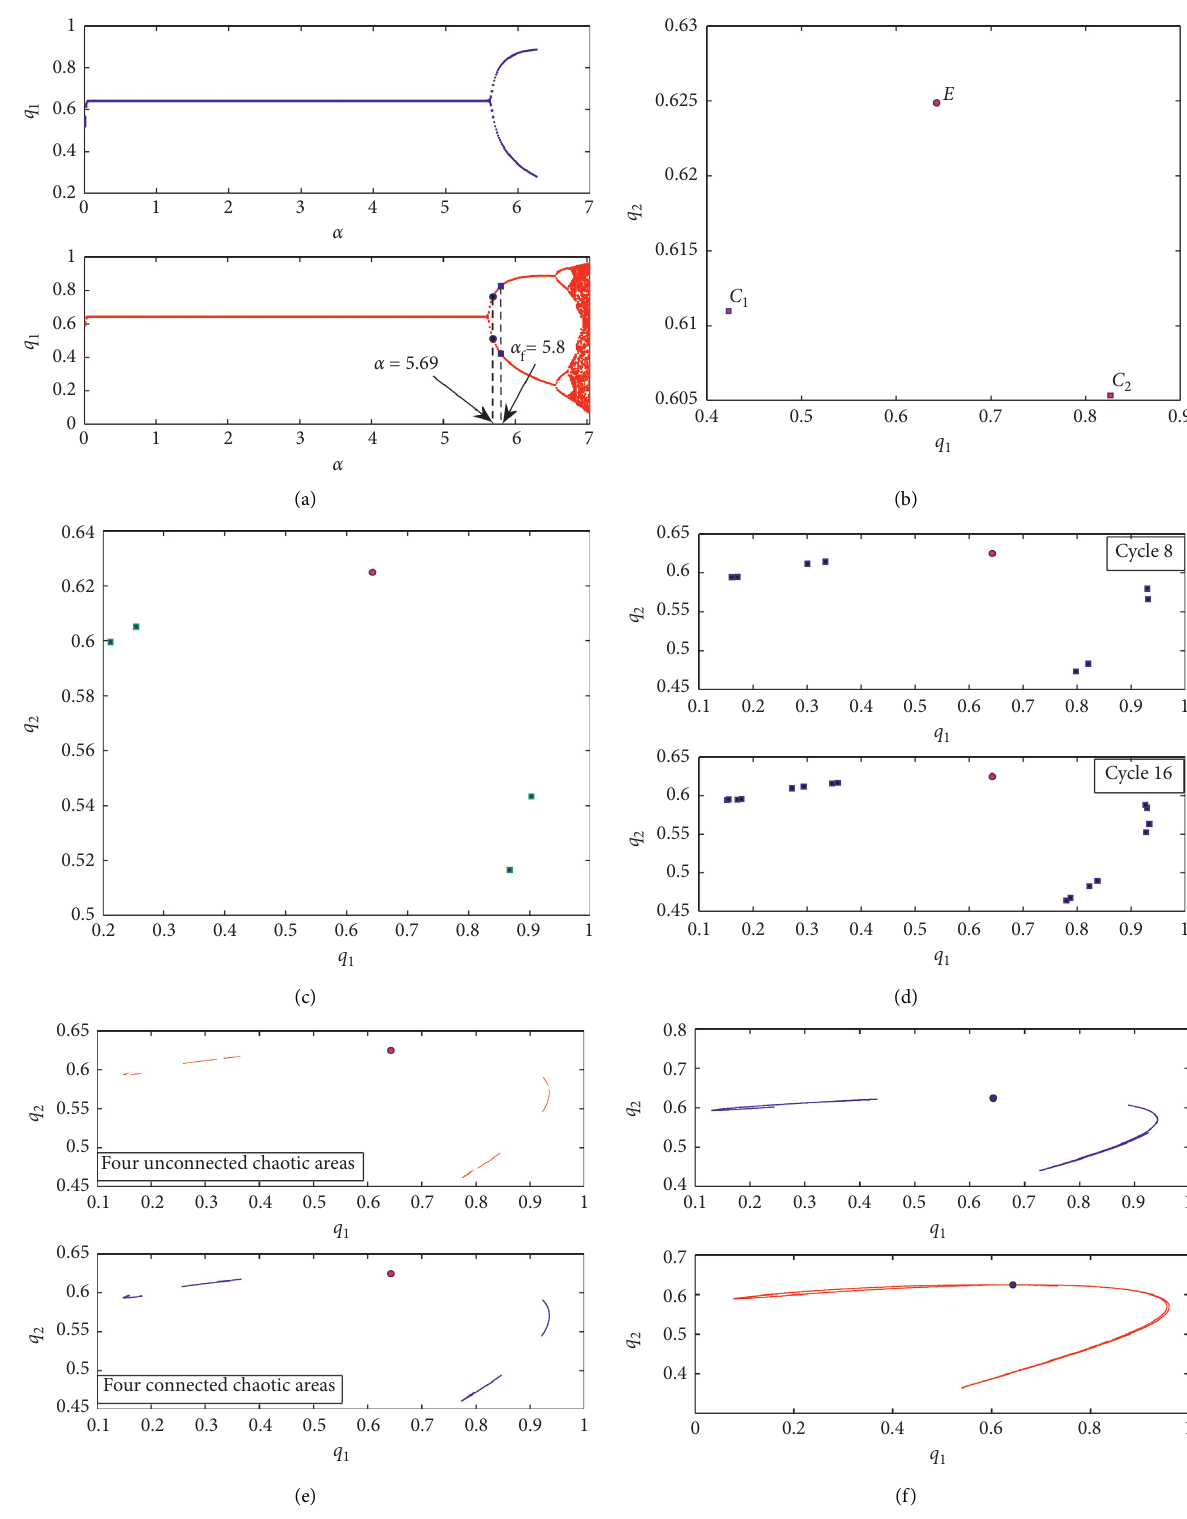
Figure 1: The fixed parameters are c , x ) � ( 0 . 40 , 0 . 11 ) (red color) and ( x ( x 0 , 1 0 , 2 for period 4-cycle at α � 6 . 58. (d) Phase plane for period 8-cycle and 16-cycle at α � 6 . 738 and α � 6 . 77, respectively. (e) Phase plane of the four pieces chaotic areas at α � 6 . 78 and α � 6 . 82, respectively. (f) Phase plane of the one-piece and two-piece chaotic